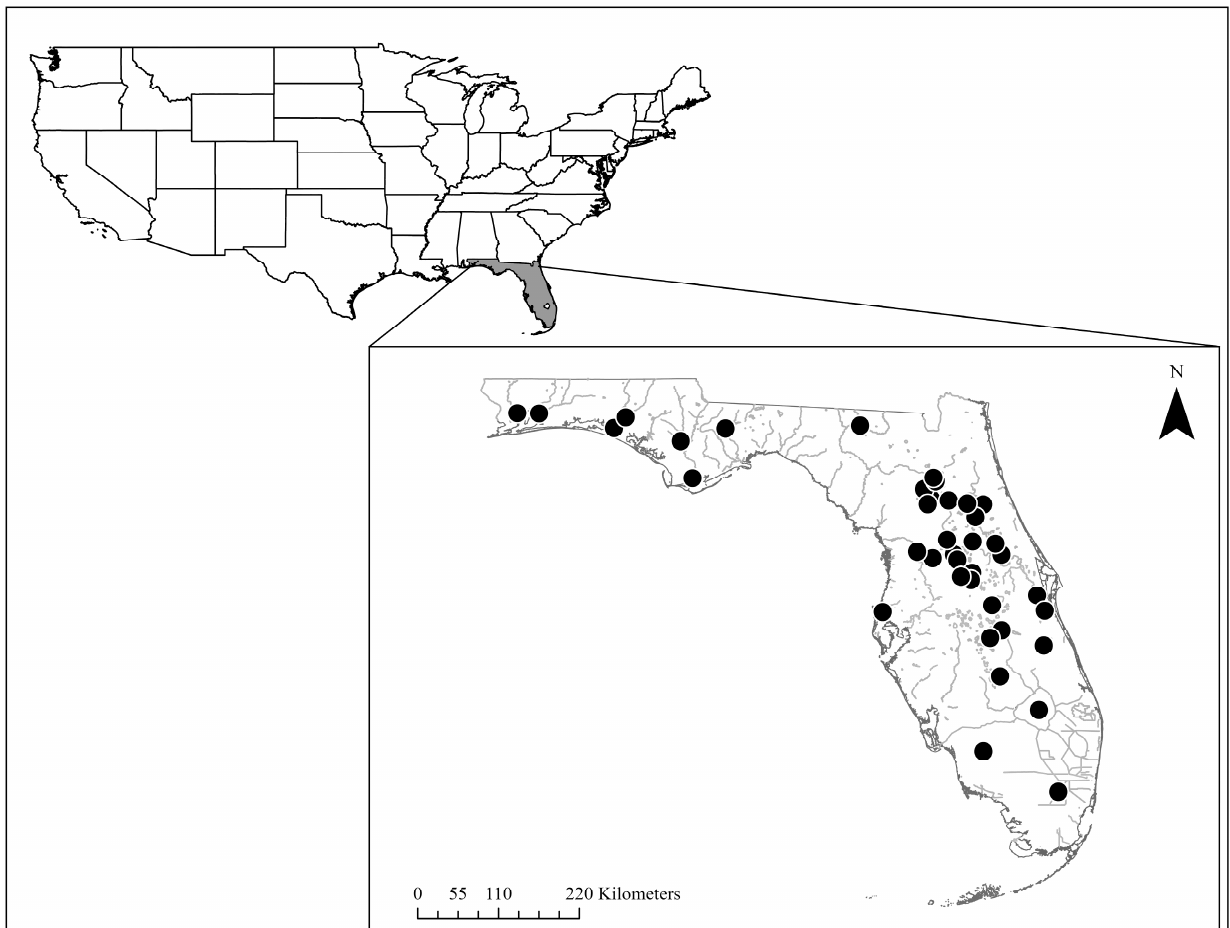
Figure 1. Map of waterbodies (black dots) currently included in Florida’s statewide Freshwater Fisheries Long-Term Monitoring program.